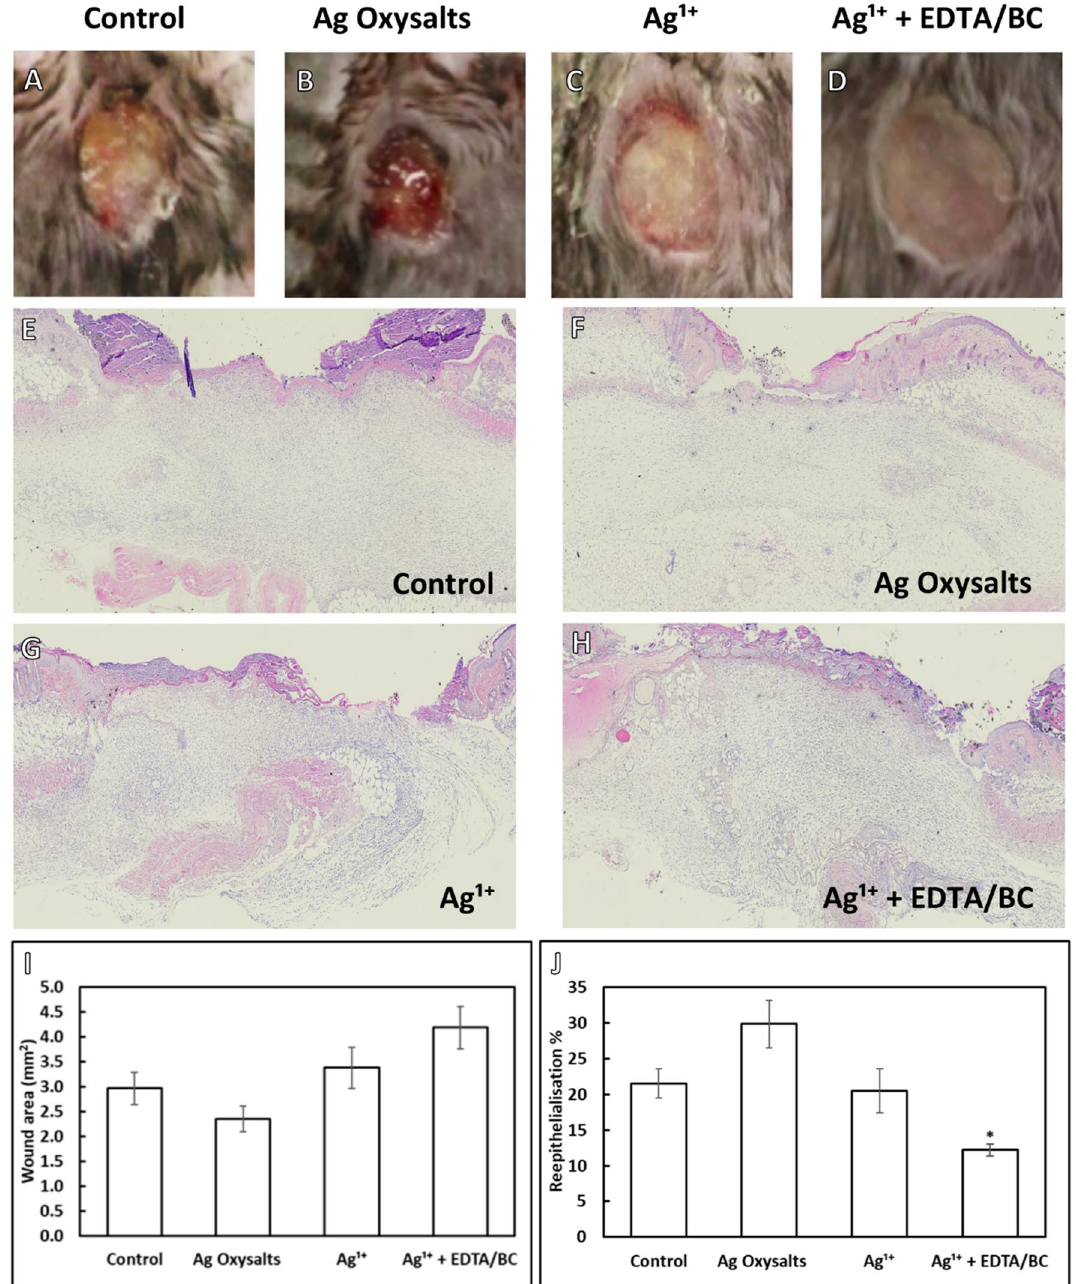
Figure 6. Effects of silver wound dressing on healing of uninfected full-thickness excisional murine wounds. ( A – D ) representative macroscopic images of wounds following three days treatment with a non-antibacterial control dressing and silver dressings. ( E – H ) Representative haematoxylin and eosin-stained wound sections. Quantification of wound area ( I ) and percentage reepithelialisation ( J ) calculated from histological sections